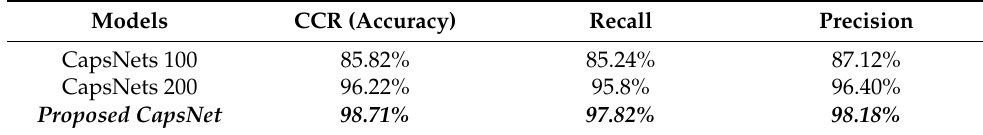
Table 5. Performance